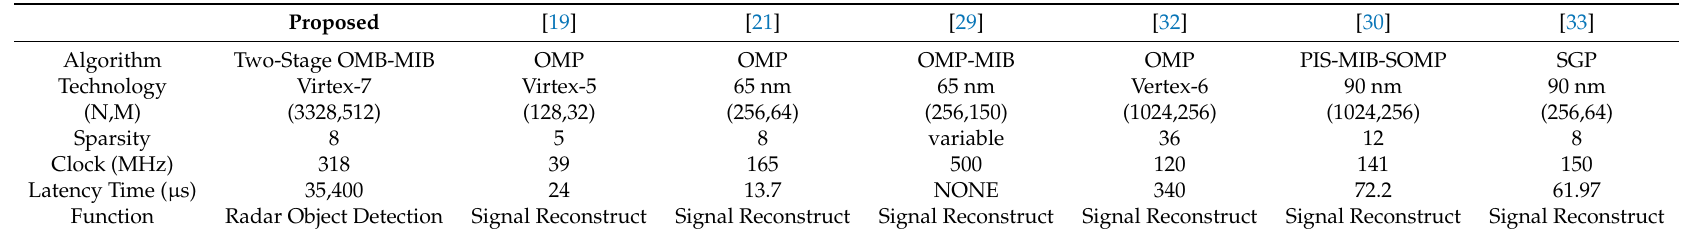
Table 2. VLSI implementations of OMP